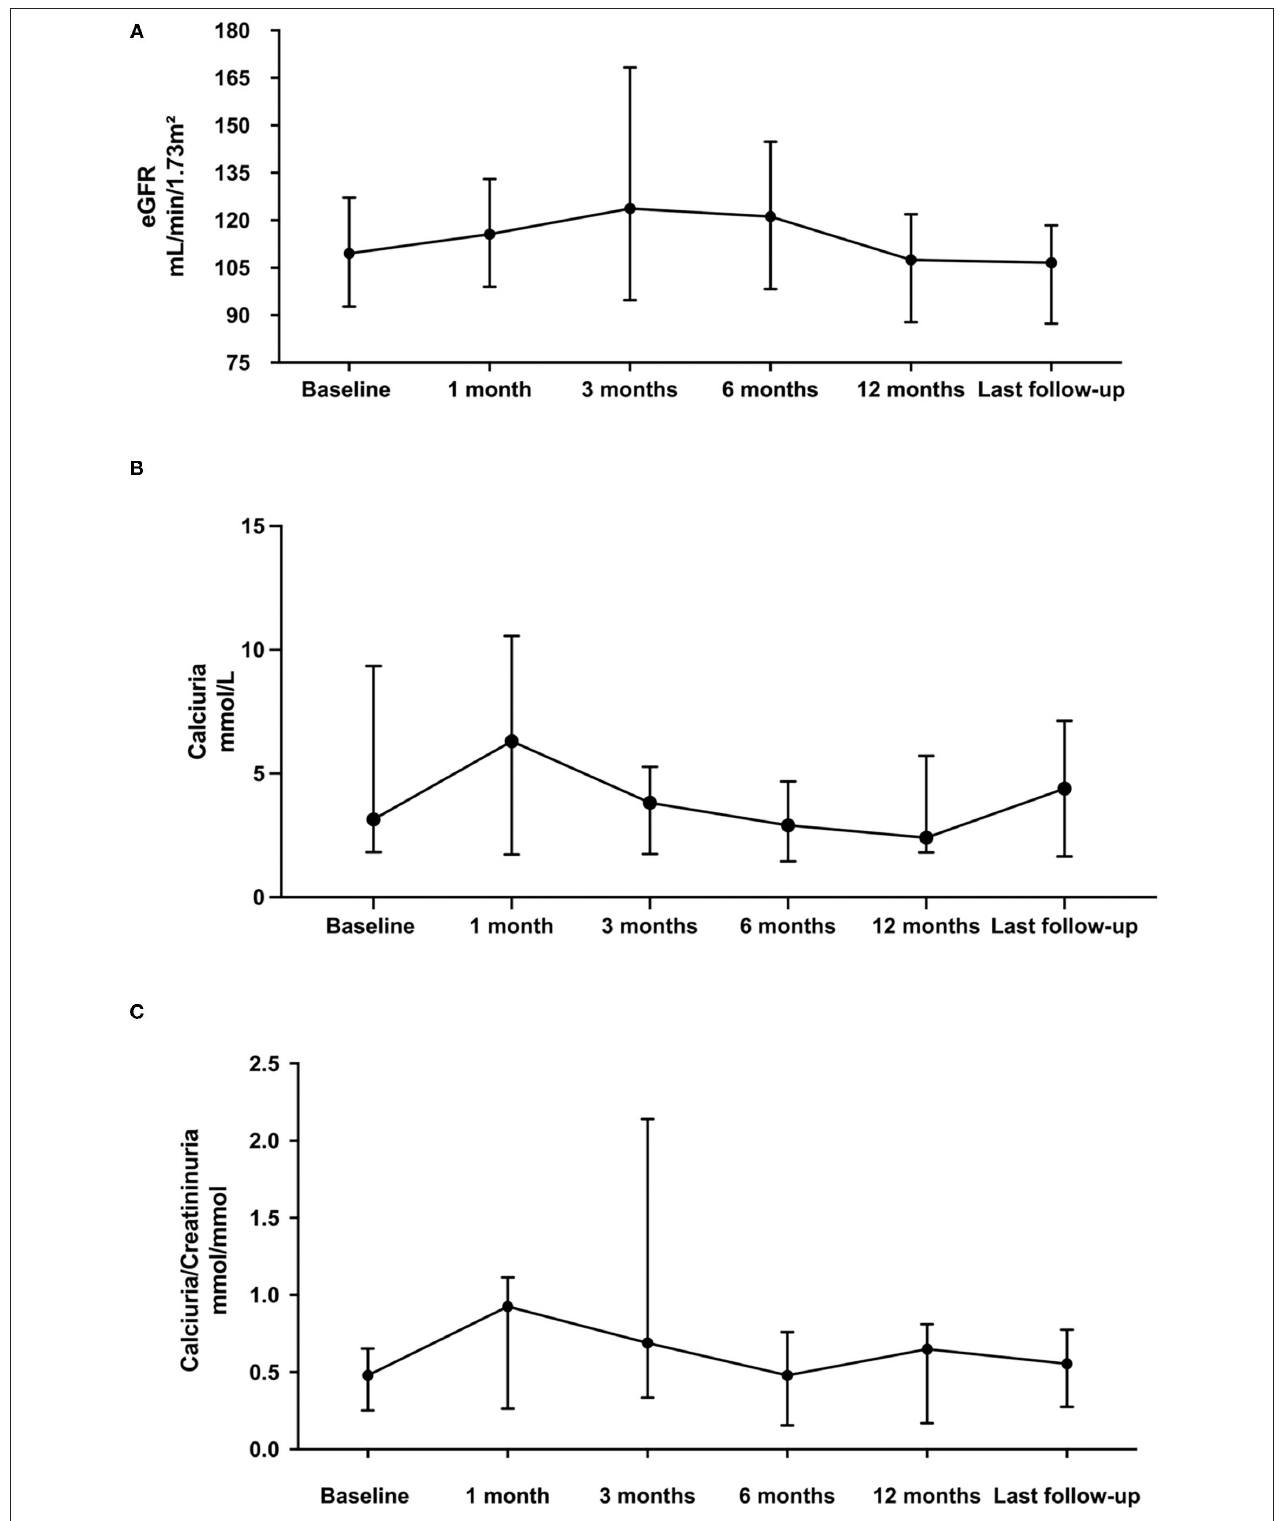
FIGURE 2 | Comparison of eGFR (A) , calciuria (B), and urinary calcium/creatinine ratio (C) on one voiding sample data at teriparatide initiation and during follow-up. Each dot on the graph represents median with interquartile range of biomarker levels at the different time-points. Statistical analyses were performed with Kruskall Wallis test: p , not statistically significant